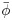
Strong structured connectivity with row balance generates high coherence even as chaos persists.(A) Sample activity of 10 randomly chosen neurons, ϕj, and coherent mode activity, ϕ¯, in black. Strong structured connectivity with row balance subtraction to the random component of connectivity yields chaotic activity that is highly coherent with switching-like behavior. (B) Normalized autocorrelation of coherent mode, q¯(τ), in red. Average normalized autocorrelation of the residuals, qδ (τ), in blue. Shaded regions show standard deviation over 25 initial conditions of the same connectivity. Strong structured connectivity yields coherent mode dynamics that are qualitatively different from those of the residuals. J1 = 15.8 for both (A) and (B), compare to Fig 1C and 1E, respectively. (C) Coherence, χ, as a function of J1 is independent of network size. Coherence appears to approach 1 as J1 is increased demonstrating that chaos persists even as fluctuations in the residuals shrink (See also S4 Fig). Coherence is averaged over 30 realizations of the connectivity for each N, excluding the few fixed points and limit cycles that occur for larger J1 (2 out of 30 or less for the largest values of N). (D) Largest Lyapunov exponent as a function of J1. Thick line shows average over 10 realizations, small dots show values for individual realizations, and shaded region is standard deviation. All but a small fraction of realizations are chaotic, even in the region where χ > 0.9. N = 4000 and g = 2 in all panels unless noted otherwise.